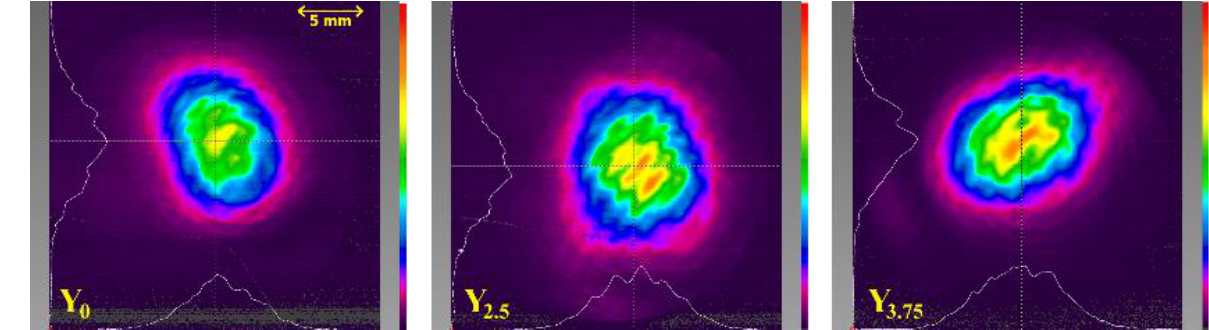
Figure 12. The transverse intensity output beam profiles measured at a distance of 590 mm from OC for maximum pumping.